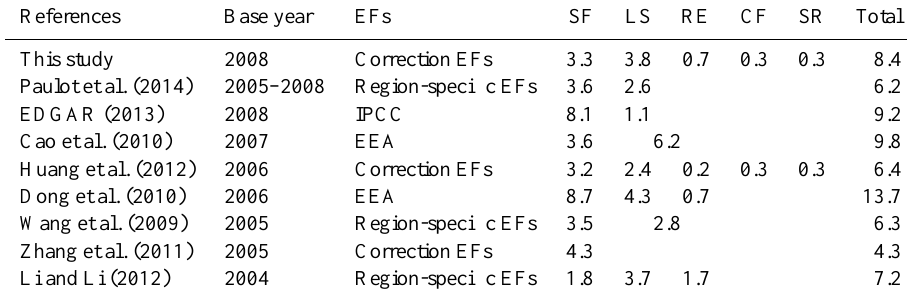
Table 1. Total NH 3 emissions (TgNH 3 yr − 1 ) ; source profile by sector after 2004 and their comparisons with previous studies. Note: SF refers to synthetic fertilizer application; LS refers to livestock manure spreading; RE refers to rural excrement; CF refers to cake fertilizer; SR refers to straw returning. 6.2 represents the sum of LS and RE in Cao et al. (2010); 2.8 represents the sum of LS and RE in Wang et al.